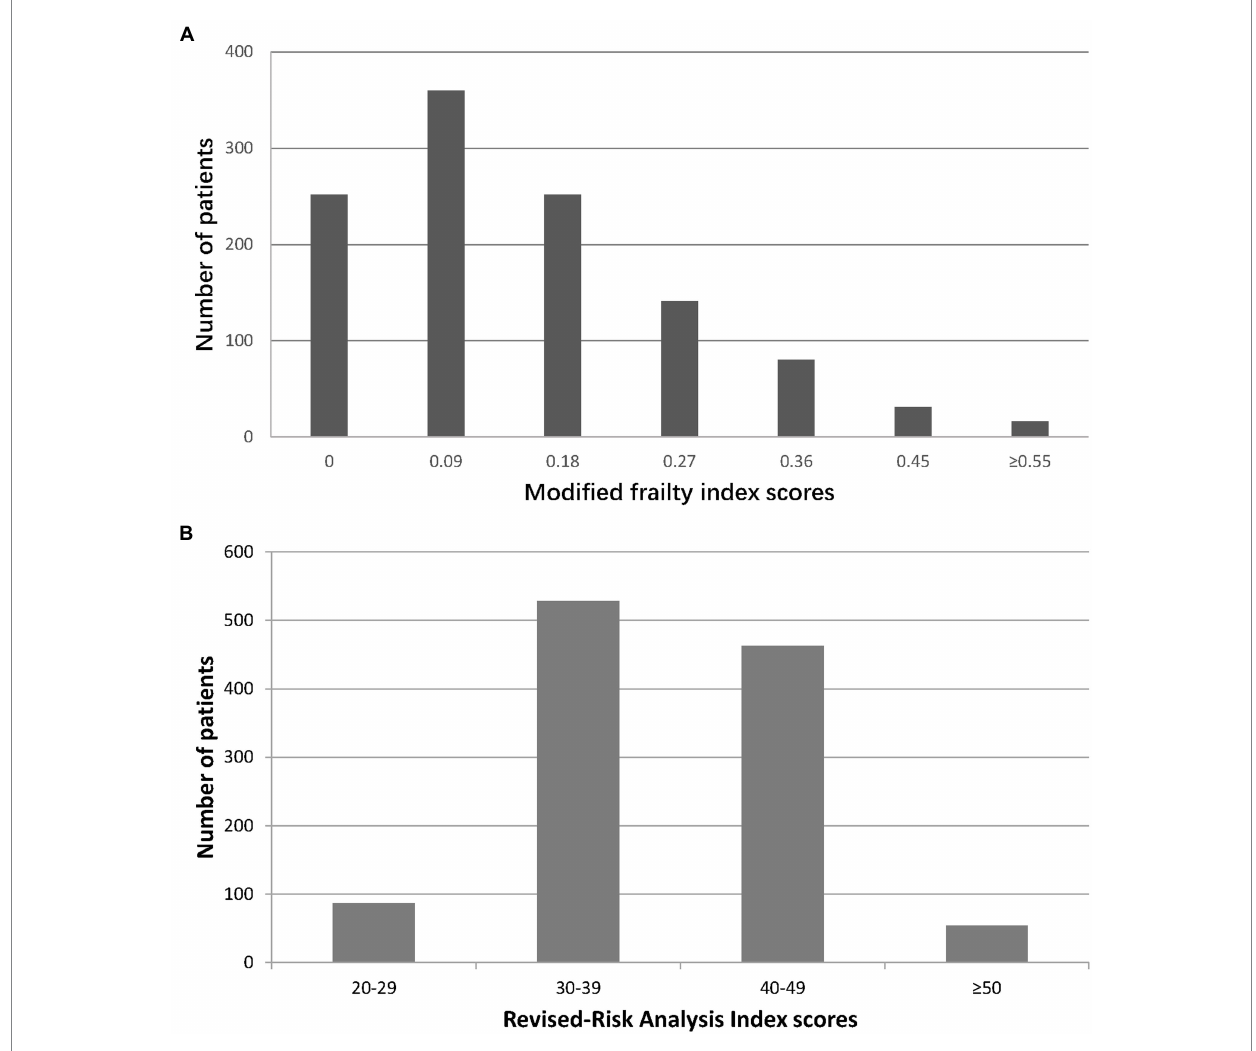
FIGURE 2 Distribution of frailty scores in the study cohort. (A) Modified frailty index; (B) Revised-Risk Analysis